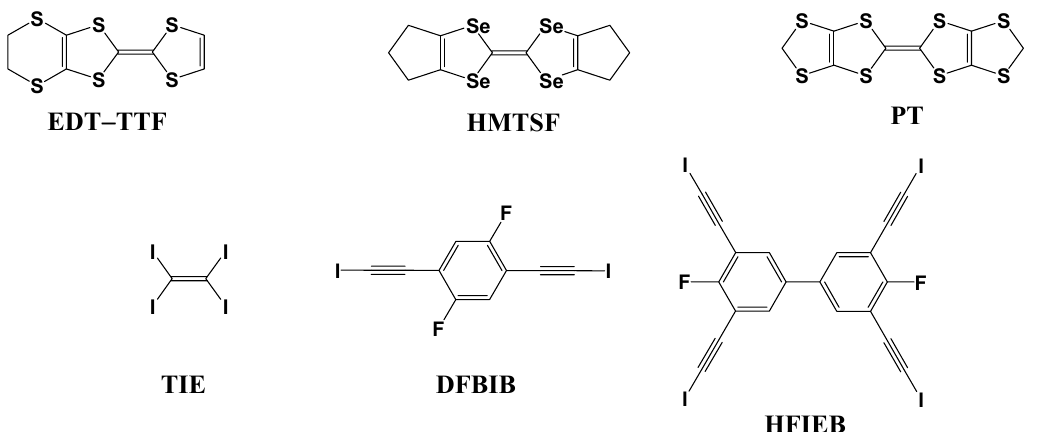
Figure 29. The chemical structures of donor molecules ( EDT–TTF , HMTSF , and PT ) and iodine-containing neutral molecules ( TIE , DFBIB , and HFIEB ).